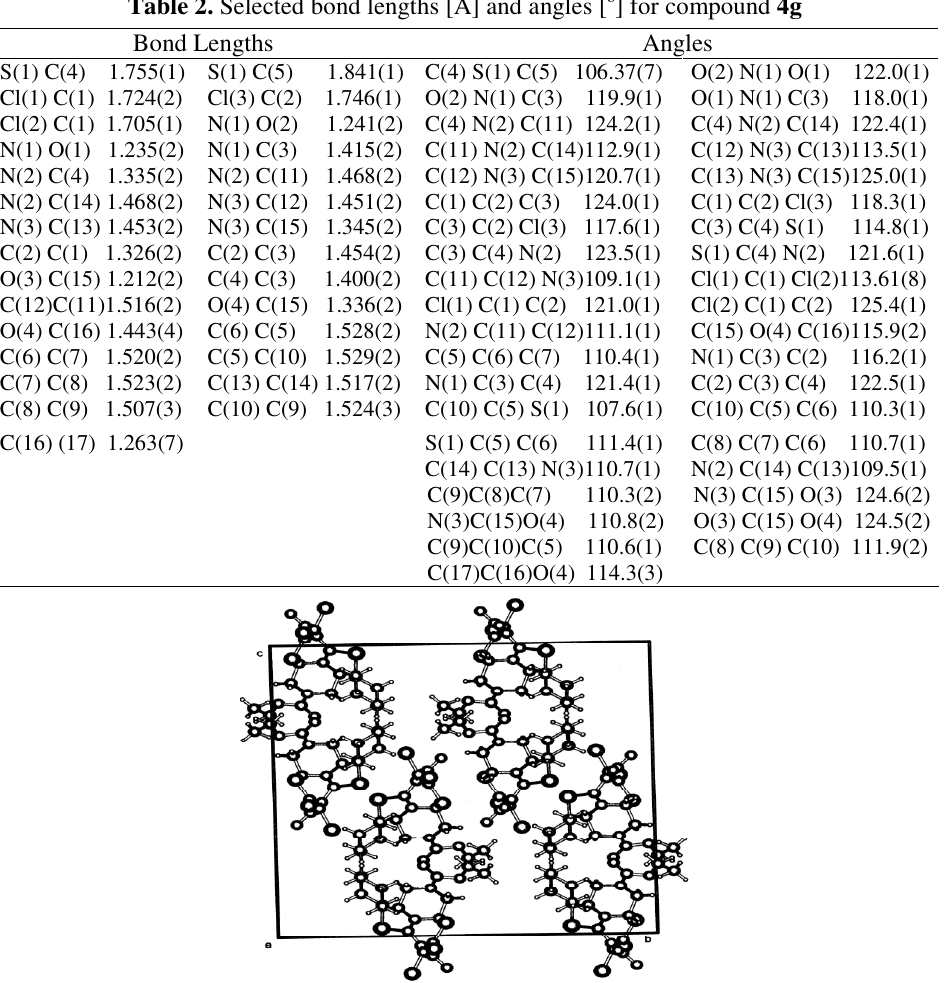
Figure 3. Packing diagram of 4g ; molecular overlap view from the